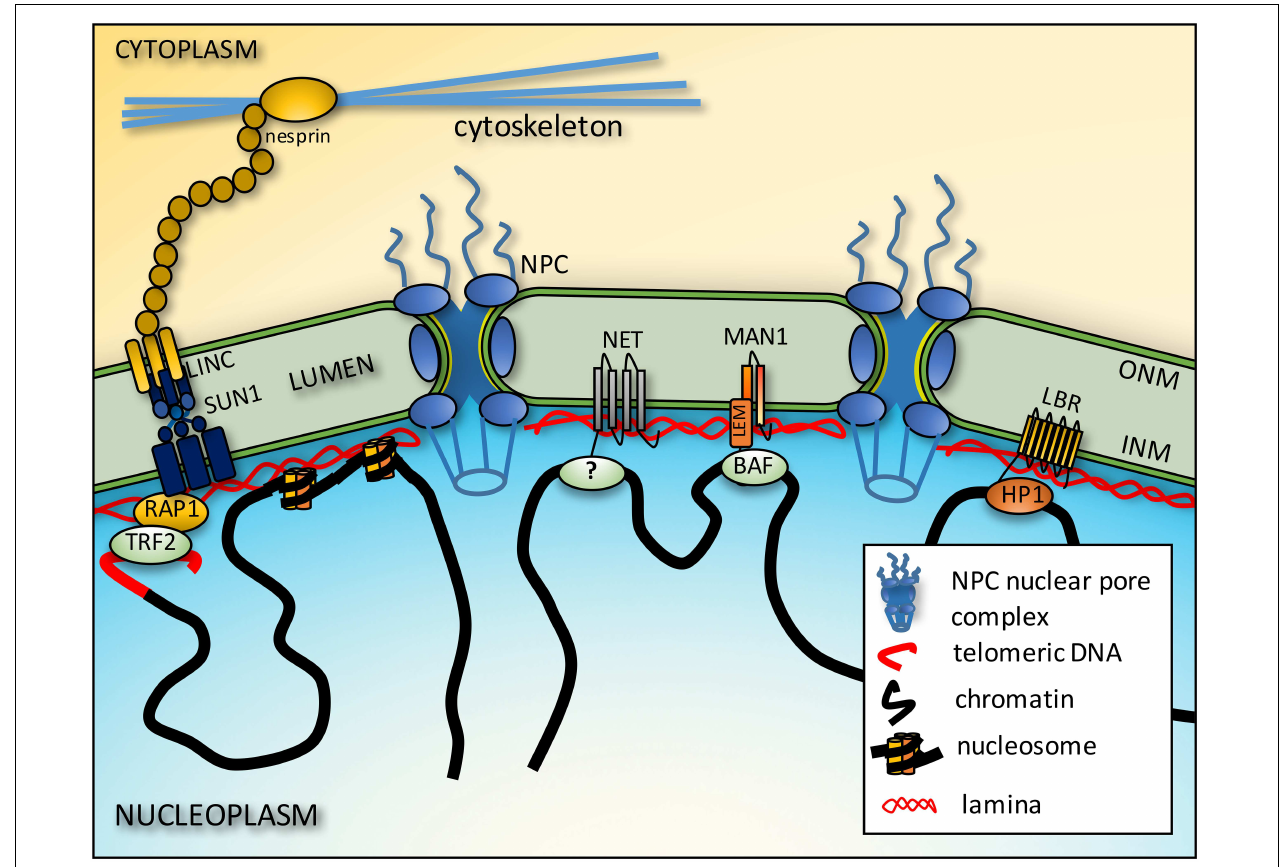
FIGURE 1 | Connections between chromatin and the NE. Telomeres interact with the NE from interactions of proteins on the telomeres such as RAP1 and proteins embedded in the inner nuclear membrane (INM) such as SUN1. These interactions in turn may be stabilized by further connections across the lumen of the NE to outer nuclear membrane (ONM) nesprins that in turn connect to cytoplasmic filaments. The intermediate filament lamin polymer that lines the INM interacts with core histones to also tether chromatin to the NE. There are also more general interactions between LEM domain (a domain shared by LAP2 β , emerin and MAN1) NETs and the chromatin protein barrier-to-autointegration factor (BAF), but some NETs appear to have more tissue-specific interactions though the chromatin partners responsible have yet to be identified (?). Finally, some NETs preferentially bind heterochromatin proteins such as LBR binding heterochromatin protein 1